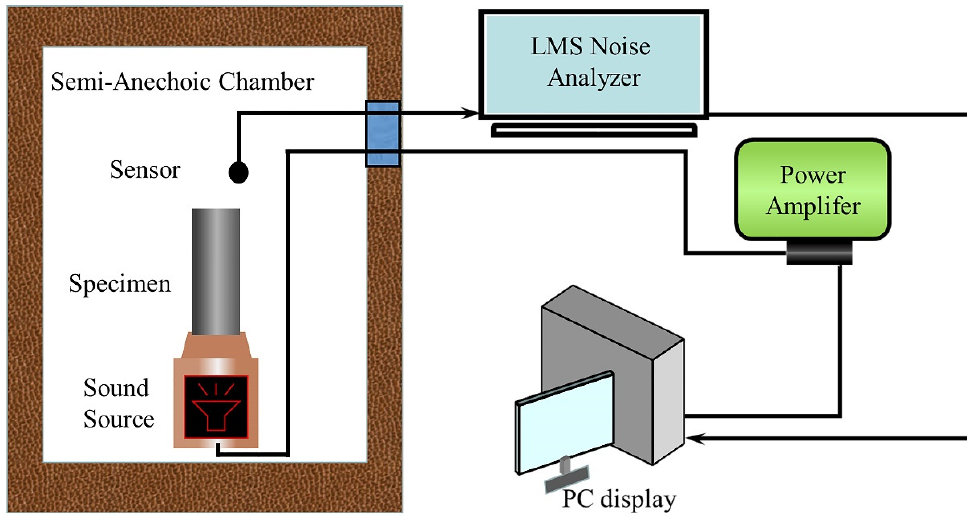
Figure 5. Schematic diagram of the experimental setup of insertion loss.